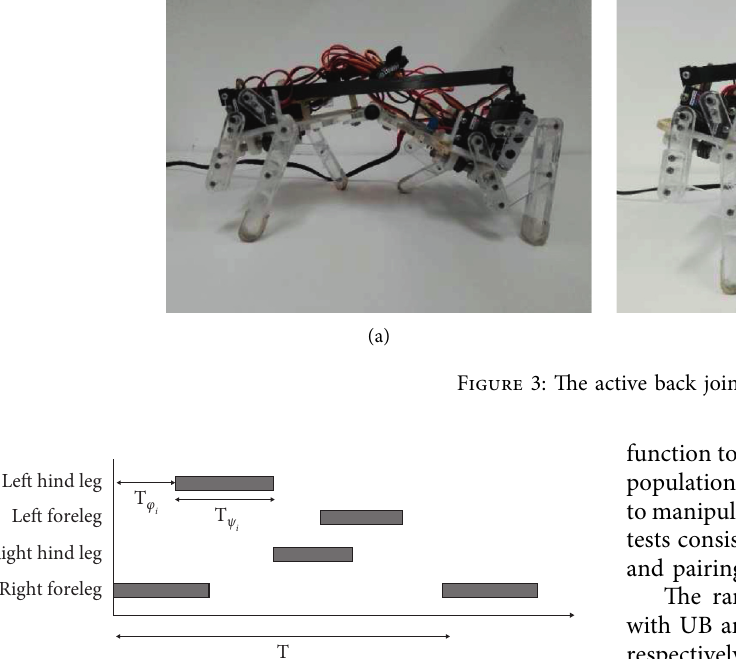
Figure 4: A quadrupedal robot gallop gait example. Τ indicates the gait cycle time duration. Here, Τ φ i and Τ ψ i indicate the time phase and time duration of the left hind leg,